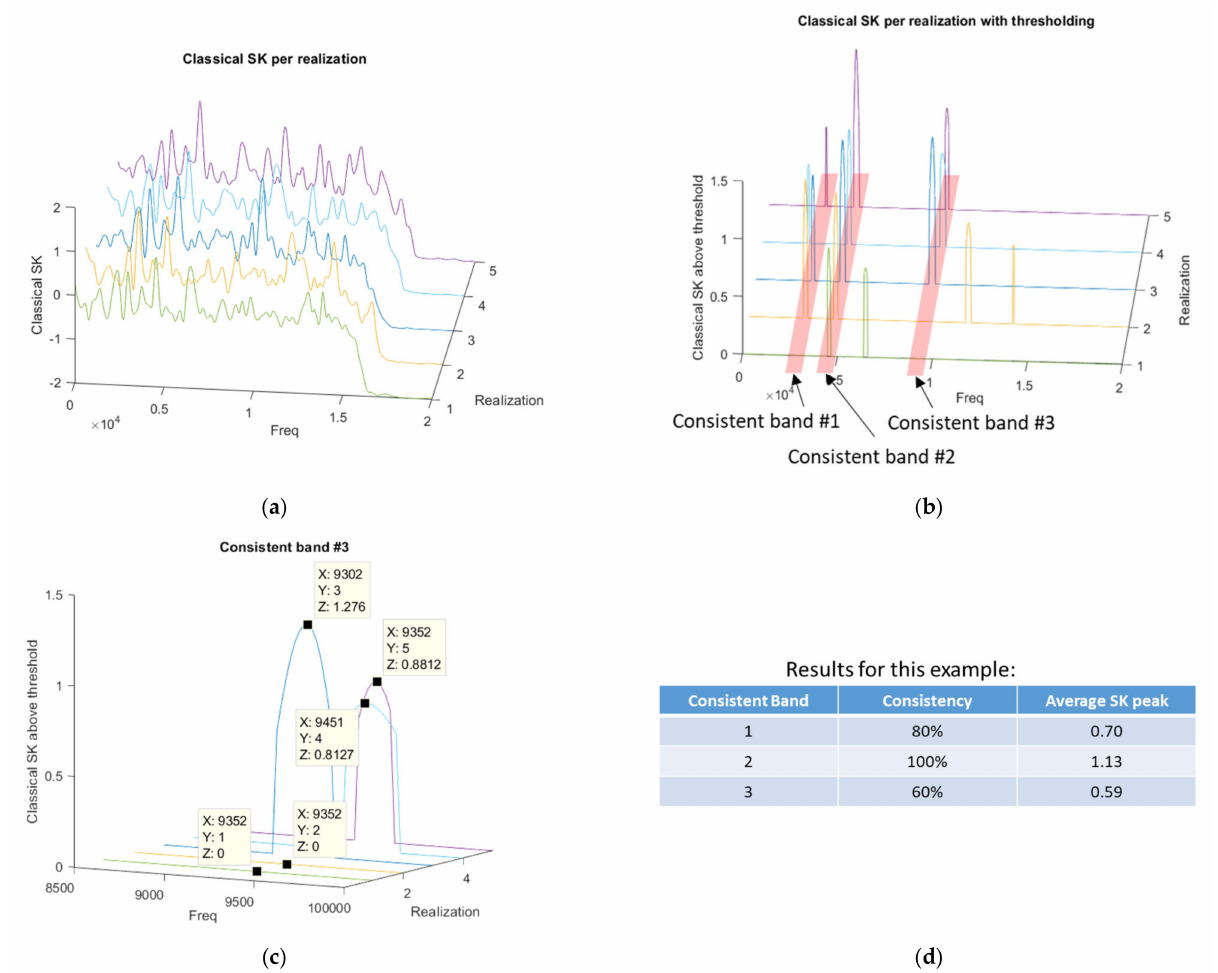
Figure 2. Representation of the differences between the first novel consistency vector and the second novel consistency vector with SK values, considering a 5 realization example; ( a ) Classical SK per realization; ( b ) Identification of SK above the SK threshold and resulting consistent frequency bands; ( c ) Calculating the SK peak values for each consistent band; ( d ) Comparison of the resultant novel consistency and novel consistency with SK